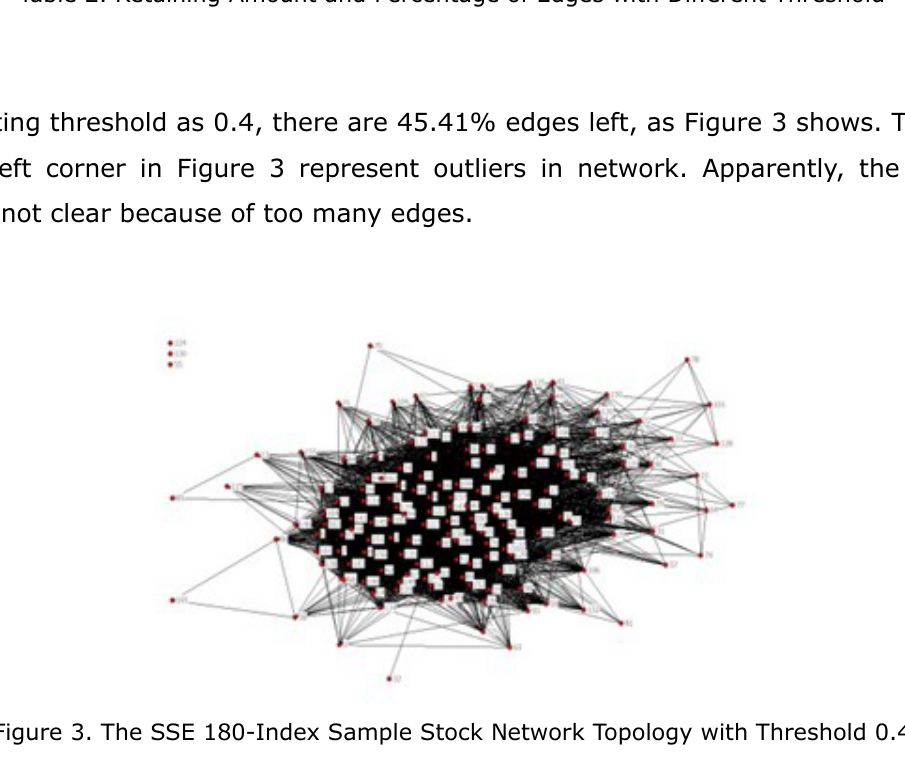
Table 2. Retaining Amount and Percentage of Edges with Different Threshold